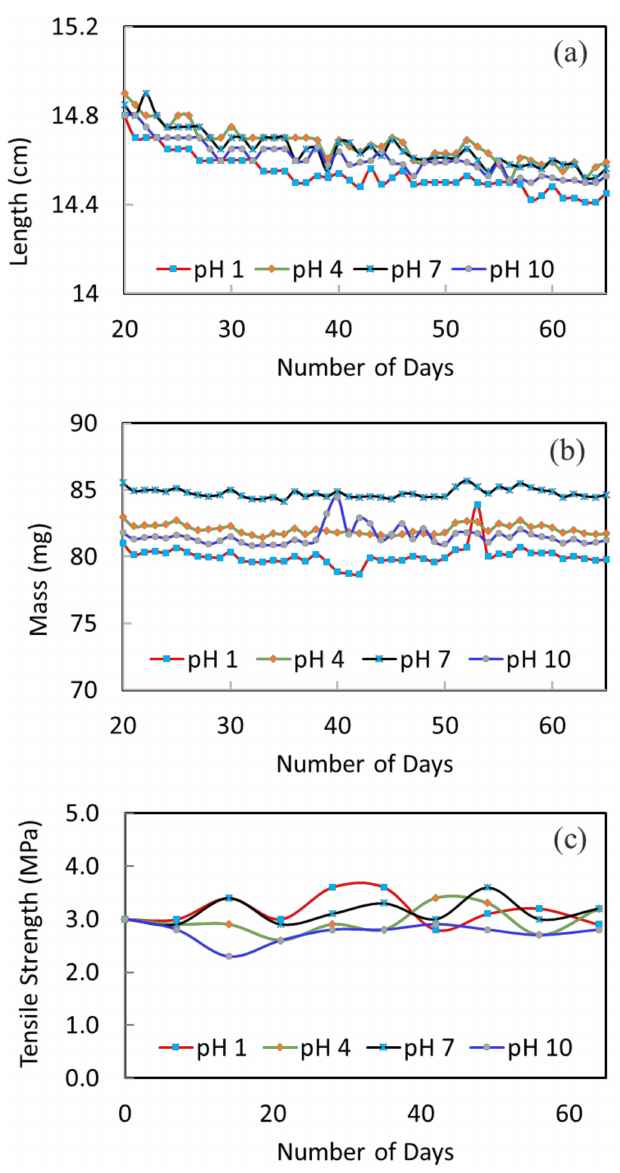
Figure 3. The variation of fiber ( a ) length, ( b ) mass and ( c ) tensile strength after been immersed in the different pH